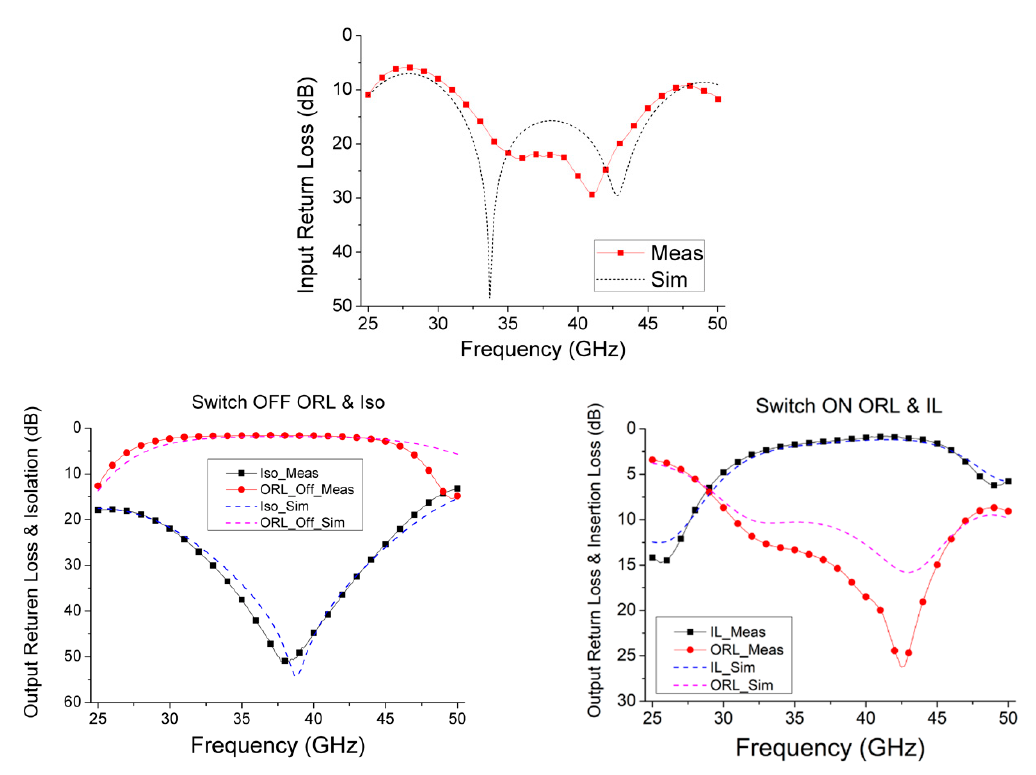
Figure 12. Measured small-signal performance of the fabricated chip with simulation results included.